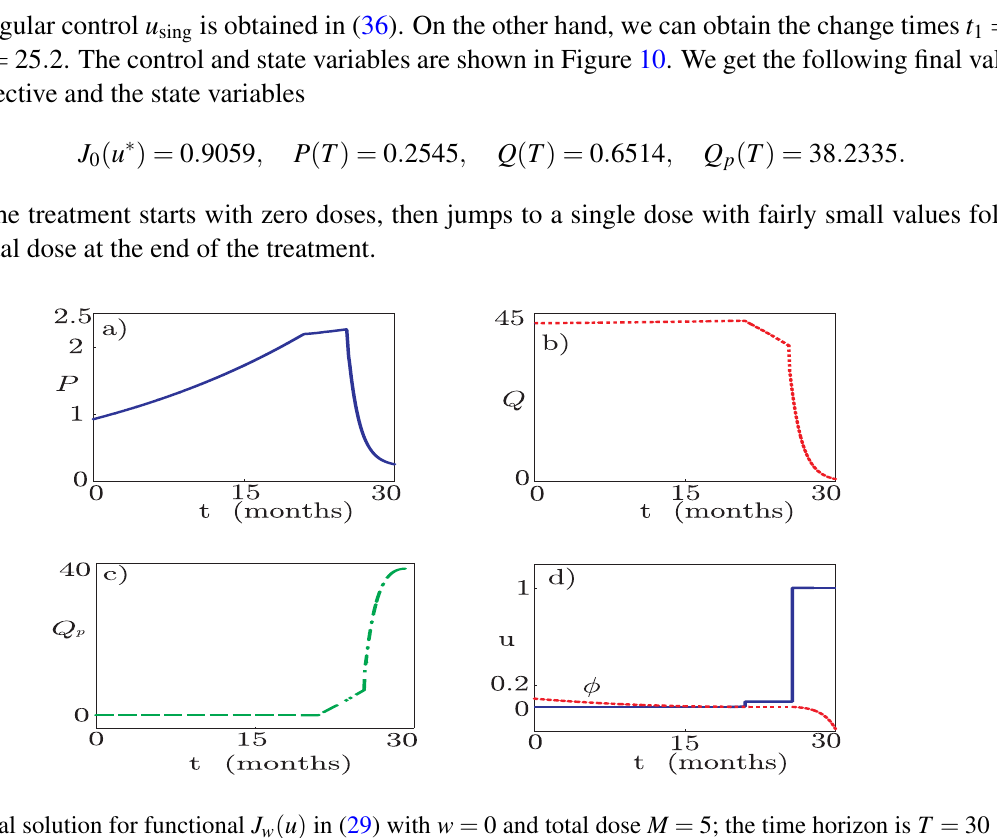
Fig. 10 Optimal solution for functional J w ( u ) in (29) with w = 0 and total dose M = 5; the time horizon is T = 30 months. Top row : a) proliferative cells P , b) nonproliferative quiescent cells Q ; Bottom row : c) damaged quiescent cells Q p , d) optimal control u ∗ ( t ) and switching function φ ; the switching function φ ( t ) is zero on the singular arc [ t 1 , t 2 ]